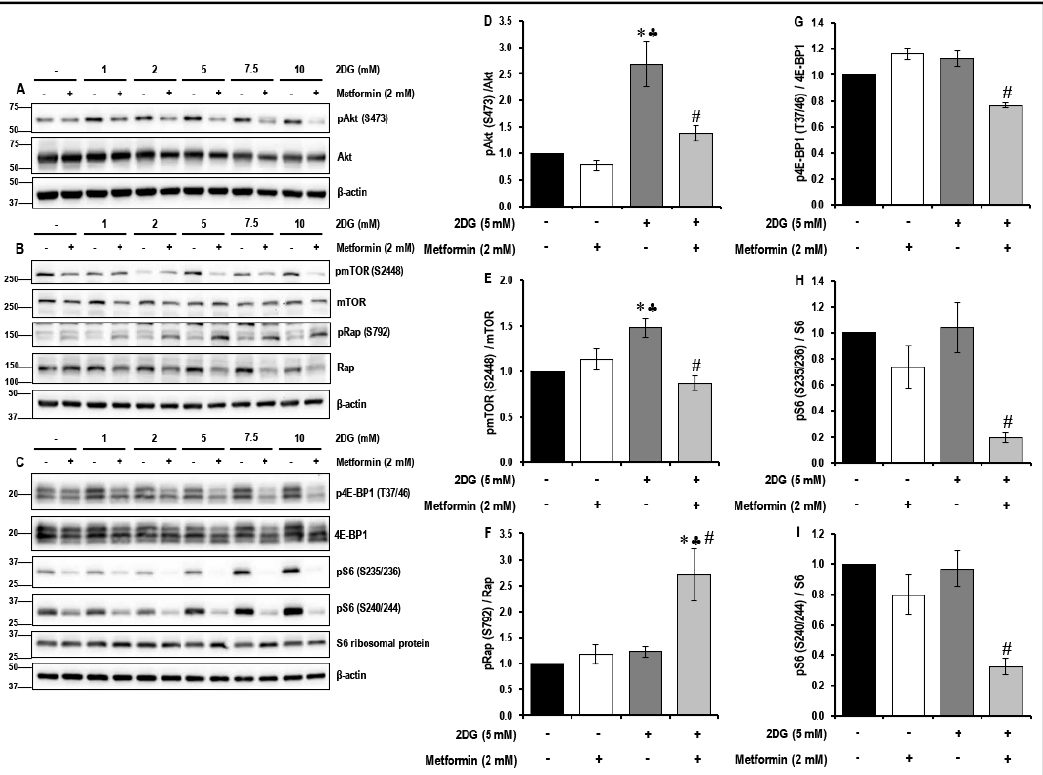
Figure 3. The levels of protein kinase B / mammalian target of rapamycin (Akt / mTOR) pathway-related proteins in metformin-treated normal glucose- and 2DG-exposed MMECs (48 h): Representative Western blot images ( A ) show the levels of phosphorylated Akt (S473) and Akt, ( B ) show the levels of phosphorylated mTOR (S2448), mTOR, phosphorylated Raptor-pRap (S792) and Raptor (Rap) and ( C ) show the levels of phosphorylated eukaryotic translation initiation factor 4E (eIF4E)-binding protein 1-p4E-BP1 (T37 / 46), 4E-BP1, phosphorylated-S6 ribosomal protein-pS6 (S235 / 236), pS6 (S240 / 244), S6 ribosomal protein after 48 h in culture. Non-treated cells and cells treated with metformin (2 mM) alone were used as suitable controls. Bar graphs represent the ratio of (normalized against β -actin loading controls) ( D ) pAkt (S473) / Akt, ( E ) pmTOR (S2448) / mTOR, ( F ) pRap (S792) / Rap, ( G ) p4E-BP1 (T37 / 46) / 4E-BP1, ( H ) pS6 (S235 / 236) / S6 ribosomal protein and ( I ) pS6 (S240 / 244) / S6 ribosomal protein after 48 h in culture. * p < 0.05 indicates significance when compared to non-treated controls, ♣ p < 0.05 indicates significance when compared to control + 2 mM metformin-treated cells and # p < 0.05 indicates significance when compared to 2DG (5 mM)-treated